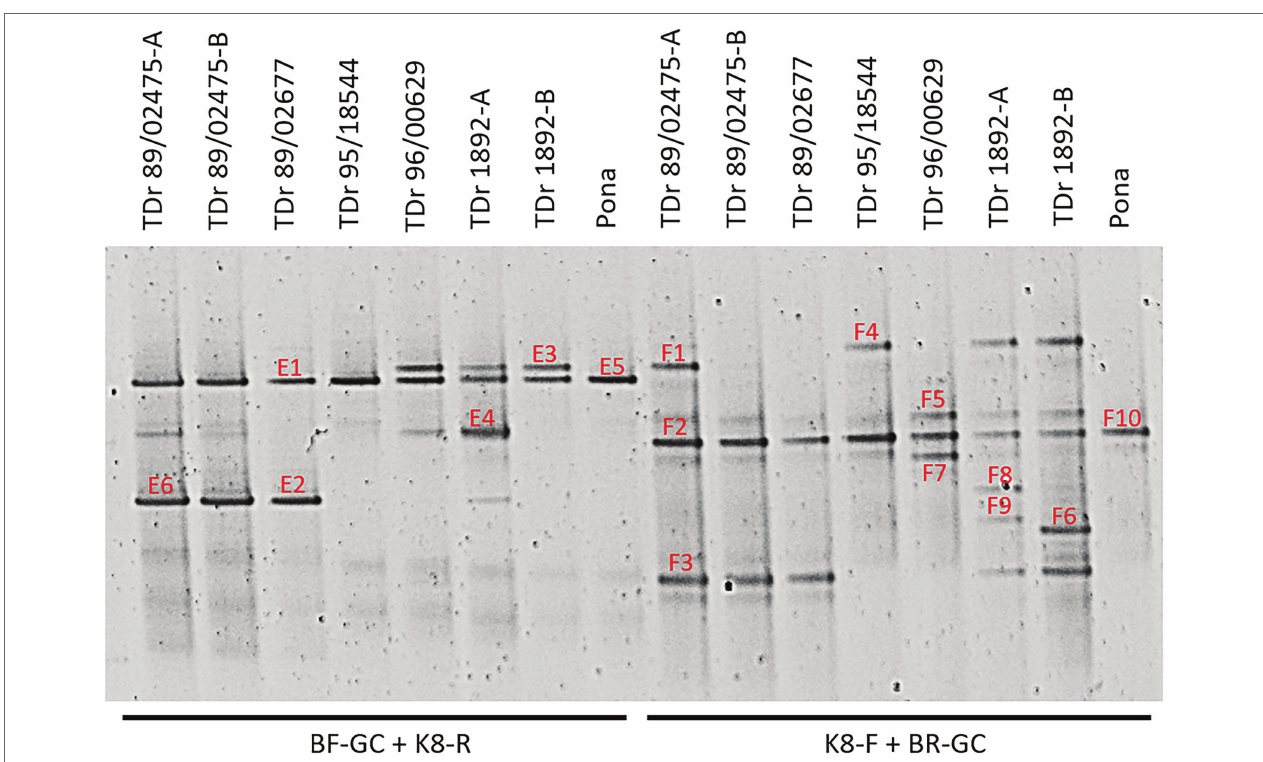
FIGURE 1 | PCR-DGGE analysis of partial reverse transcriptase ribonuclease H (RT-RNaseH) badnavirus sequences from seven Dioscorea rotundata breeding lines (labelled TDr) and one landrace (Pona) comparing PCR amplifications using the generic badnavirus primer pair with a GC clamp fused to either the forward (BF-GC) or reverse primer (BR-GC) in combination with monophyletic species group-specific primers K8-F or K8-R. Dioscorea rotundata accession TDr 89/02475-A and -B and TDr 1892-A and -B are clones of the same yam accessions. Sixteen distinct bands (E1–E6; F1–10) were excised, re-amplified, cloned and sequenced. Typically, two clones per excised DGGE band were sequenced, and both sequences are presented in Table 1 except for those which were found to be 100% identical to each